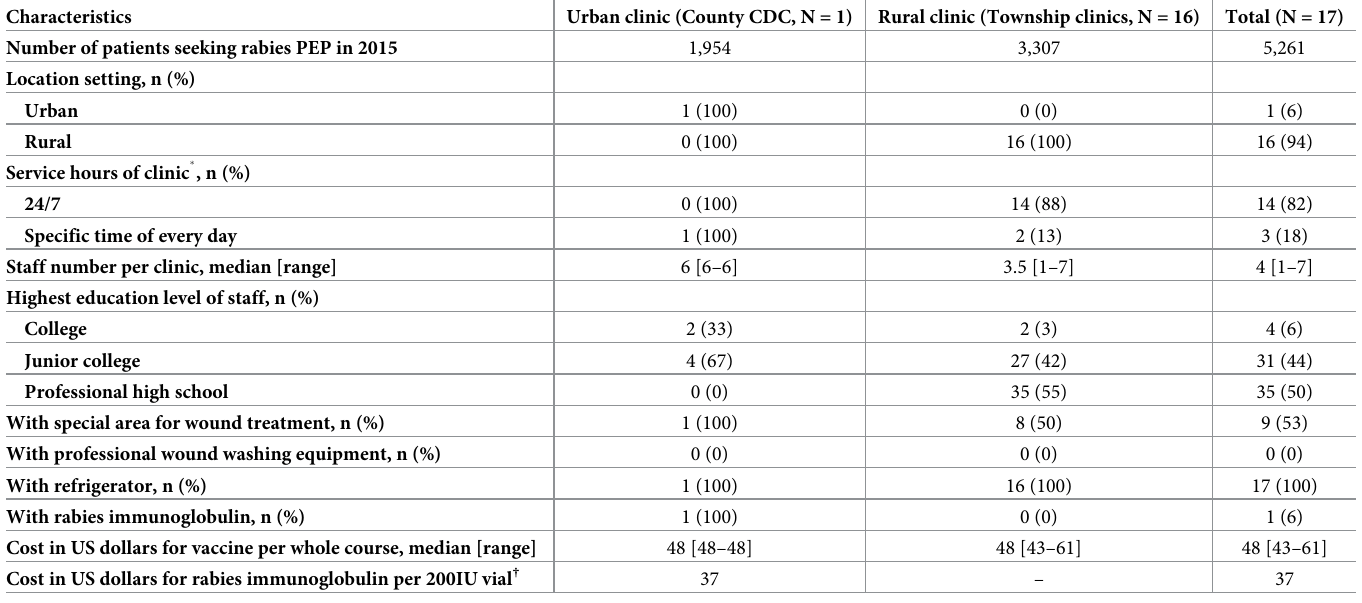
Table 1. Characteristics of 17 rabies clinics in project county A, Hunan Province, China, 2016.